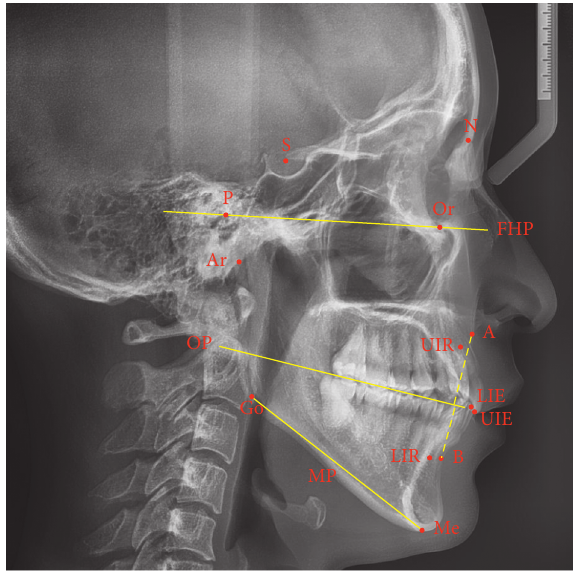
Figure 1: Cephalometric landmarks used in the study. N, Nasion; S, Sella; P, Porion; Or, Orbitale; Ar, Articulare; A, Subspinale; UIR, Upper incisor root; UIE, Upper incisor edge; LIR, Lower incisor root; LIE, Lower incisor edge; B, Supramentale; Me, Menton; Go, Gonion; FHP, Frankfort horizontal plane; OP, Occlusal plane; MP, Mandibular